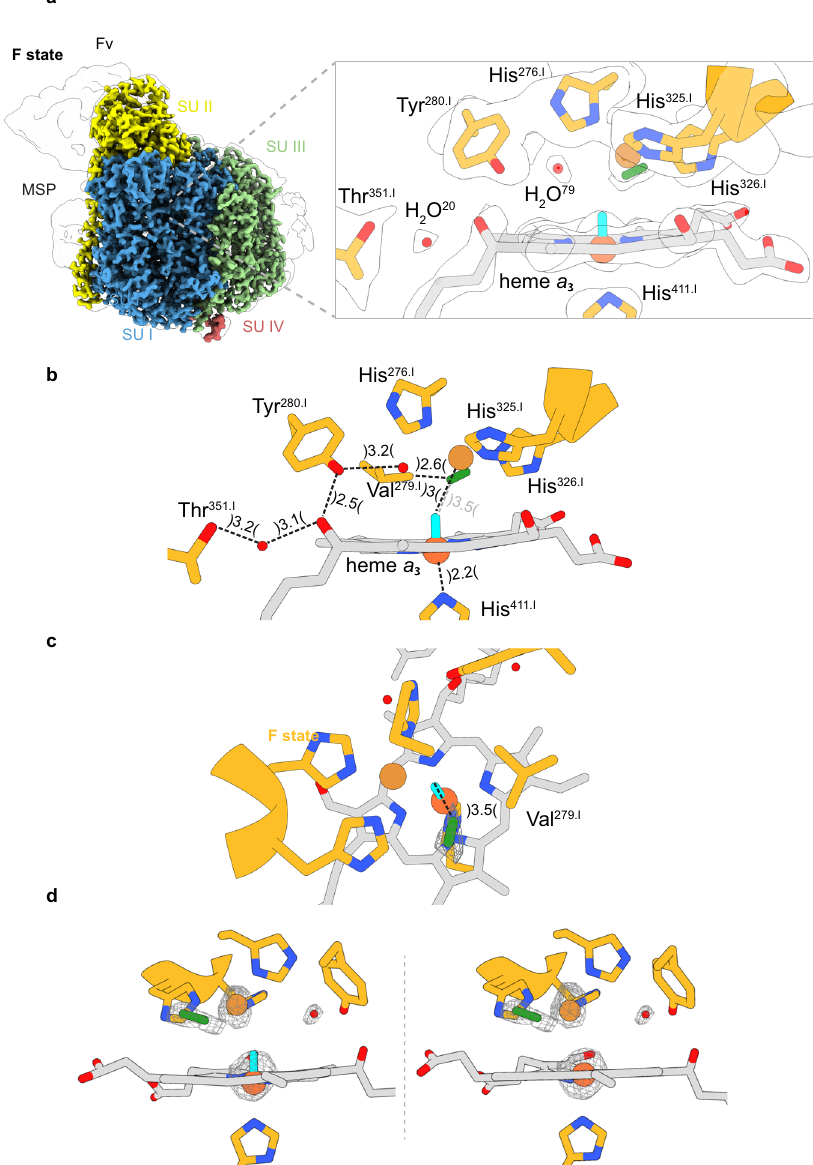
Fig. 8 Cryo-EM density map (F-state) and modelled structure of the binuclear site in C c O. a Structural overview of the binuclear site in the F -state. No bridging ligand is located between the iron (orange) and the copper (brown) atom. Instead, the density map may indicate the presence of an oxoferryl (cyan) at the heme and a dioxide species (green) in close proximity. b Measured distances (Å) for the modelled molecules at the active site. c Top view of the binuclear center of the F -state. d Modeling of the iron of heme a 3 with a bound oxygen (oxoferryl) and without. The corresponding density map is illustrated as a white surface or mesh volumes. Illustrated map densities are fi ltered to equal contour levels of